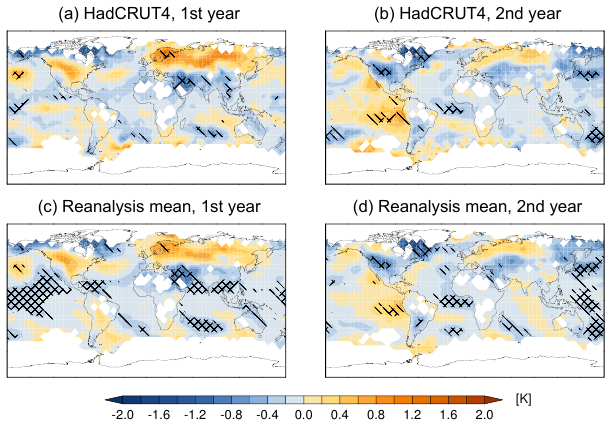
Figure 6. Observed and multi-reanalysis mean TAS anomalies (K) averaged over the first year (a, c) and second year (b, d) after the eruption and over the three volcanic eruptions Mt Pinatubo (1991), El Chichón (1982) and Mt Agung (1963). Panels (a) and (b) show the mean anomaly for the HadCRUT4 observations and panels (c) and (d) show the mean anomaly of the five reanalysis datasets, con- taining this period (Table 1). Anomalies are calculated with respect to the average over the years 1961–1990, consistent with the Had- CRUT4 dataset. Single diagonal lines correspond to the 90% and double diagonal lines to the 95% confidence level obtained by a Monte Carlo test of three independent